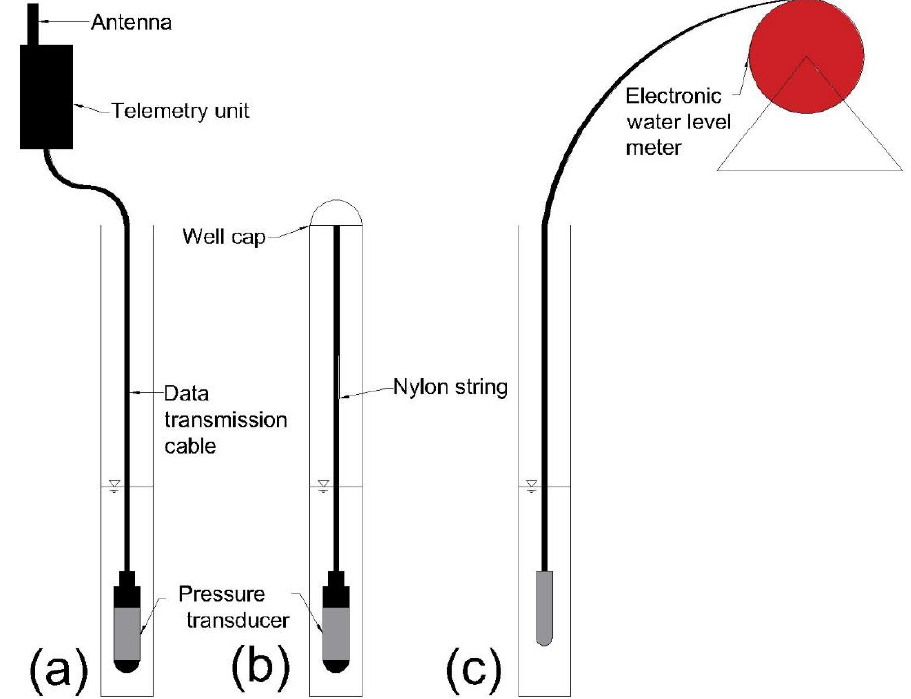
Figure 1. Three methods of groundwater level monitoring: ( a ) pressure transducers that remain deployed in a monitoring well and send continuous data via telemetry ( b ) pressure transducers that remain deployed in a monitoring well until the sensor is removed for manual data retrieval, and ( c ) manual water level meter measurements which provide a single data point per measurement event.